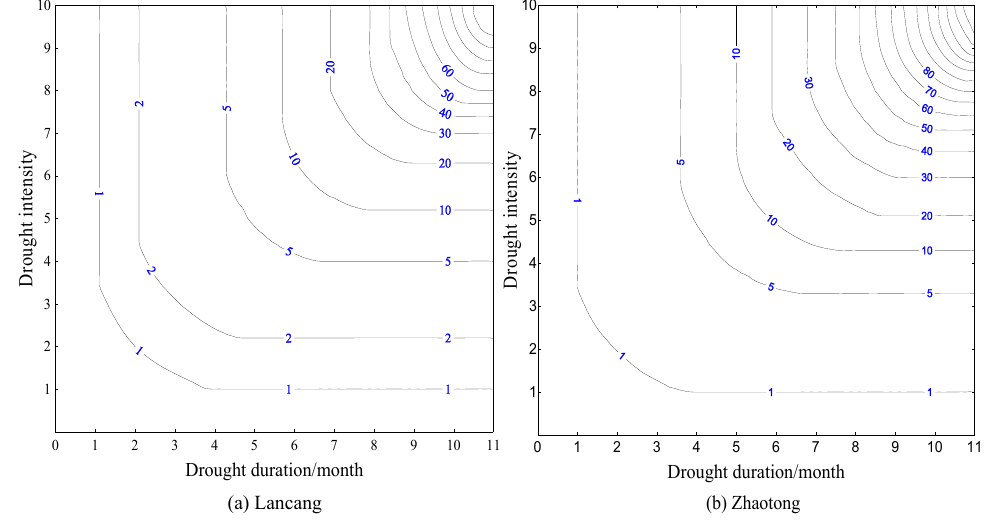
Figure 5. Joint return period contour line ( a ) Lancang; ( b ) Zhaotong.